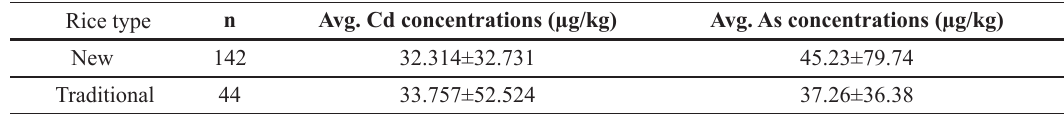
Table 2: C d and As concentrations in traditional and newly improved rice varieties.